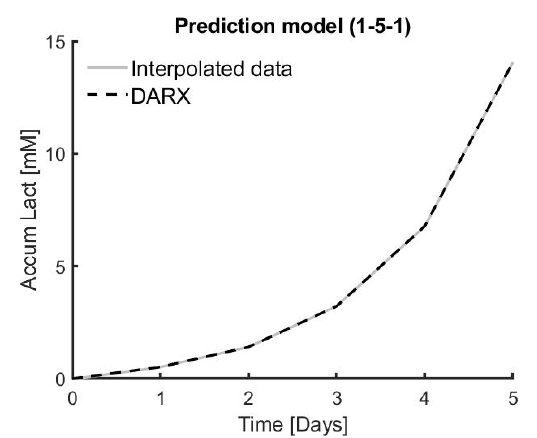
Figure 5. Visualisation of dynamic auto-regressive exogenous (DARX) model for accumalated lactate (mM) compared to the interpolated data for the experiment of donor 1, condition 5 and triplicate 1. Table 5. Accuracy measured using normalised root mean square error (NRMSE) of DARX model compared to output of the interpolated data for each condition, donor and triplicates. The DARX model used is either the one based on the corresponding experimental data (diagonal values) or on the data of an experimental triplicate. The value is NRMSE multiplied by 100 and expressed as a percentage, with 100 being a perfect fit.